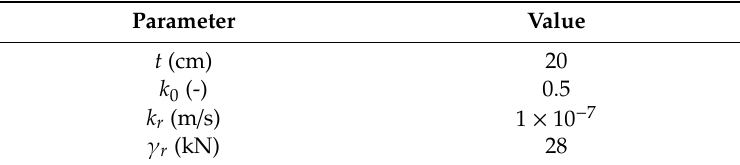
Table 4. Constant values in present study.